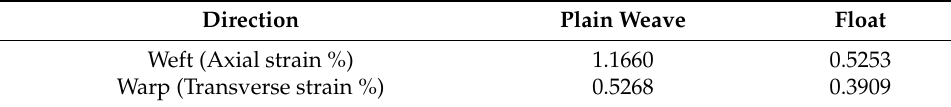
Table 3. Axial and transversal strain.